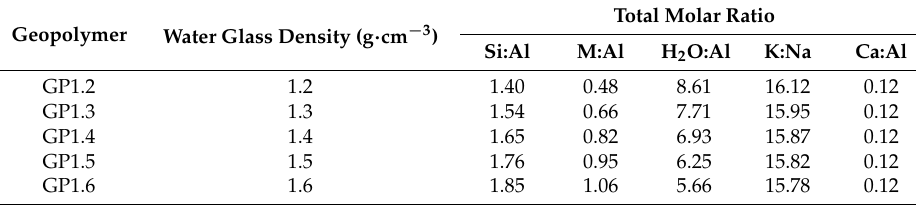
Table 2. Chemical composition of the geopolymers.